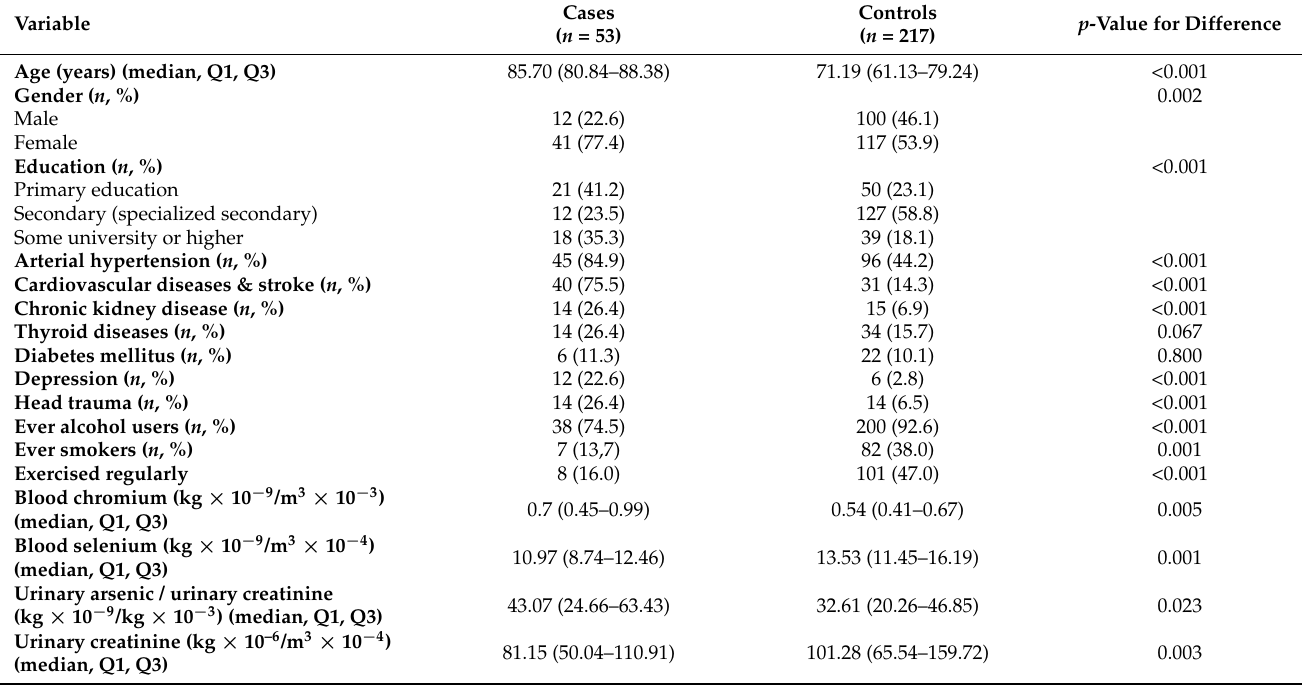
Table 1. Characteristics of Alzheimer’ disease cases and